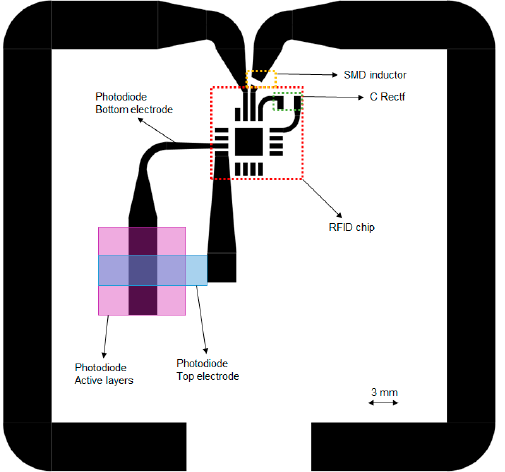
Figure 1. Layout of the radiofrequency identification (RFID) tag. The folded dipole encases a square of 5 × 5 cm 2 , and the width of the arms is 5 mm. The active area of the Organic Photodiode is given by the overlapping of a bottom Ag line and a top conductive polymer line, both with a width of 3 mm, with a total surface of 9 mm 2 .